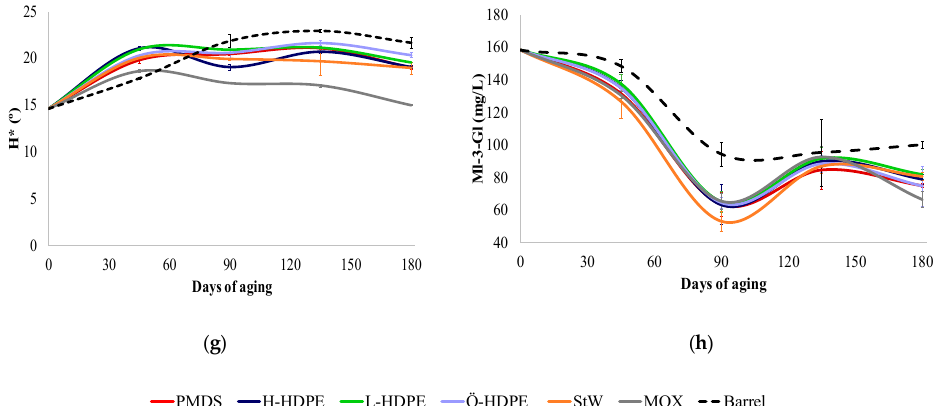
Figure 3. Evolution of some compounds during the wine aging period (180 days) using different systems. ( a ) Ionization index (Io-ln); ( b ) Color due to copigmented anthocyanins (C); ( c ) Color due to polymeric pigment (Ep); ( d ) Lightness (L*); ( e ) Red / green (a*); ( f ) Yellow / blue (b*); ( g ) Hue (H*); ( h ) Malvidin-3-O-glucoside (Mv-3-Gl). Aging systems: PDMS (polydimethylsiloxane tube); H-HDPE, L-HDPE and Ö-HDPE (high-density polyethylene); StW (stoneware); MOX (stainless steel with micro-oxygenation); and barrel (French oak barrel). Table 3. Correlation coefficients between oxygen supplied and analyzed parameters of wines from different aging systems.